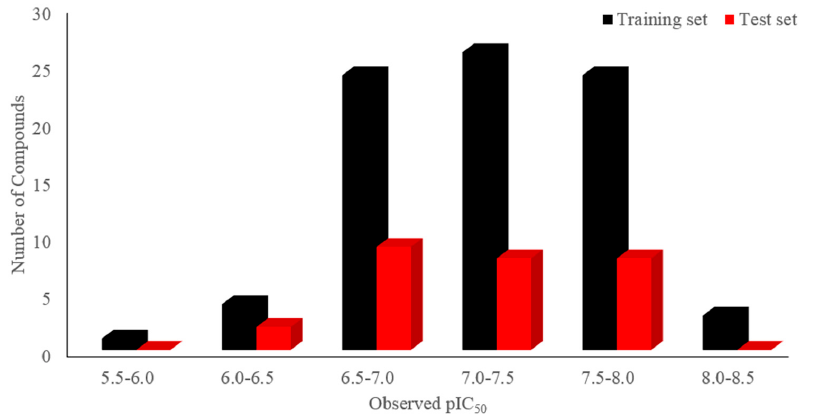
Figure 2. Distribution of the number of compounds versus their activities (pIC 50 ) of the training (colored as black) and the test (red) sets.